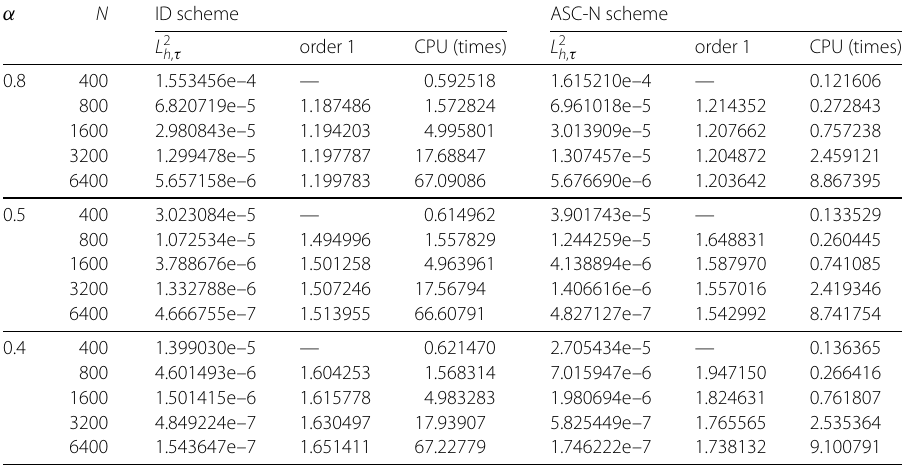
Table 2 The numerical errors and convergence orders in temporal direction ( h = 1/80) α